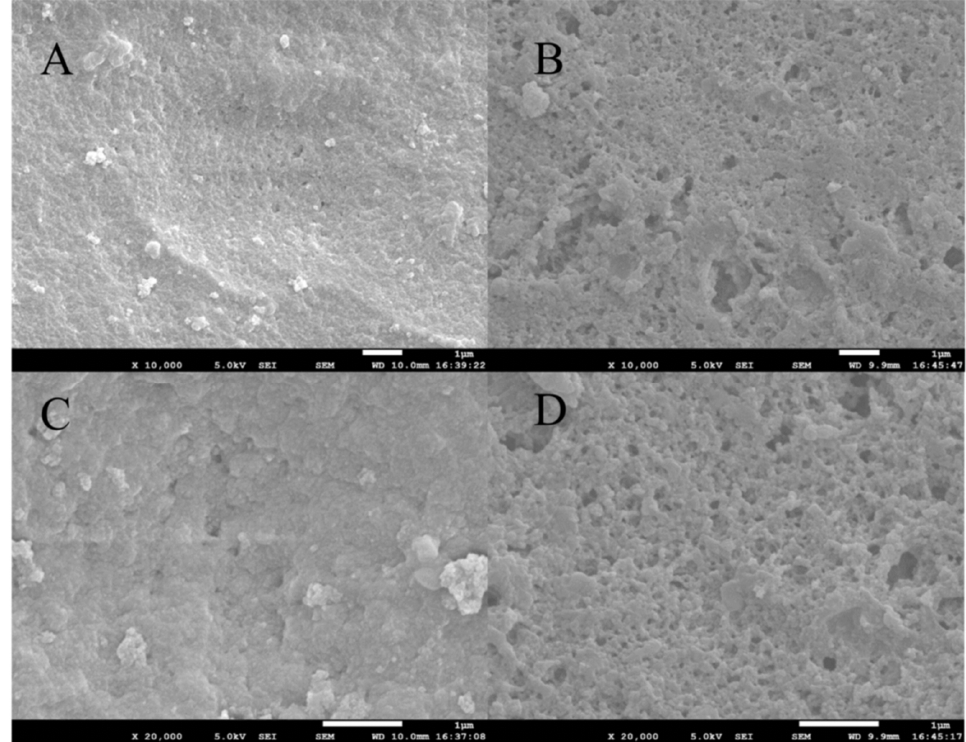
Figure 2. SEM images of ( A ) MG-MIM and ( B ) NIM at 10 K, and images of ( C ) MG-MIM and ( D ) NIM at 20 K.